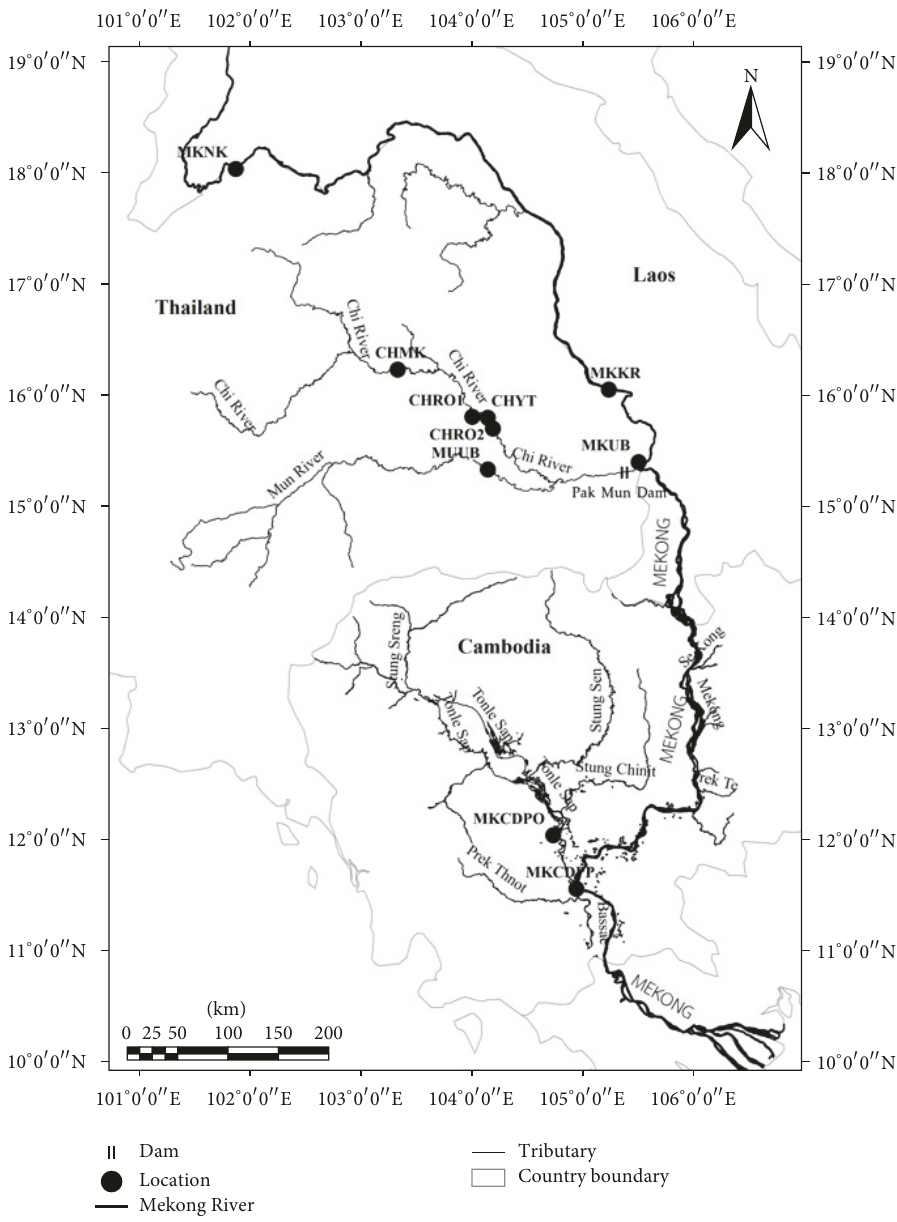
Figure 1: Sampling locations for twisted-jaw fish, Belodontichthys truncatus, are used in this study. Details of sampling sites are provided in Table 1.